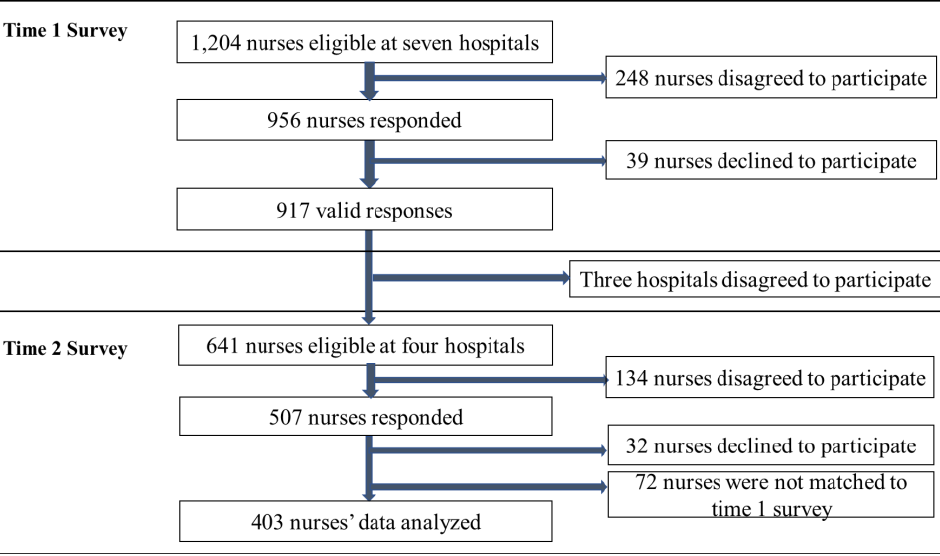
Figure 2. Data collection flow chart.